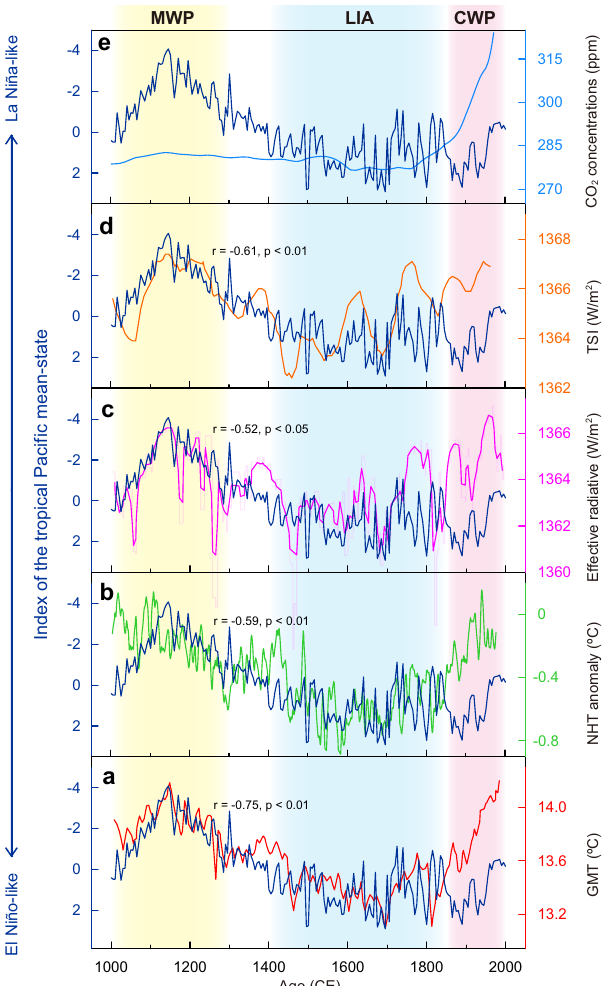
Fig. 4 Comparison of the index of the tropical Paci fi c mean-state from East Asia with possible forcing mechanisms. The index of the tropical Paci fi c mean-state reconstructed from East Asian lake sediments in this study is shown by the dark blue line in each panel. a Modeled global mean temperature (GMT) from an ECHO-G model simulation (red) 52 . b Northern Hemisphere temperature (NHT) reconstructions from proxy records (green) 53 . c Time series of effective radiative forcing integrated from global volcanic aerosols and solar irradiance (pink) 52 . d Total solar irradiance (TSI) derived from the common fl uctuations in the production rates of the cosmogenic nuclides of 14 C and 10 Be production rates (orange) 51 . e Global CO 2 concentration (light blue) 70 . Correlation coef fi cients and p -values between the index of the tropical Paci fi c mean- state and time series of forcing mechanisms during the pre-industrial era (1000 – 1850 CE) are shown in each panel. The yellow shading indicates the MWP, the blue shading indicates the LIA, and the red shading indicates the